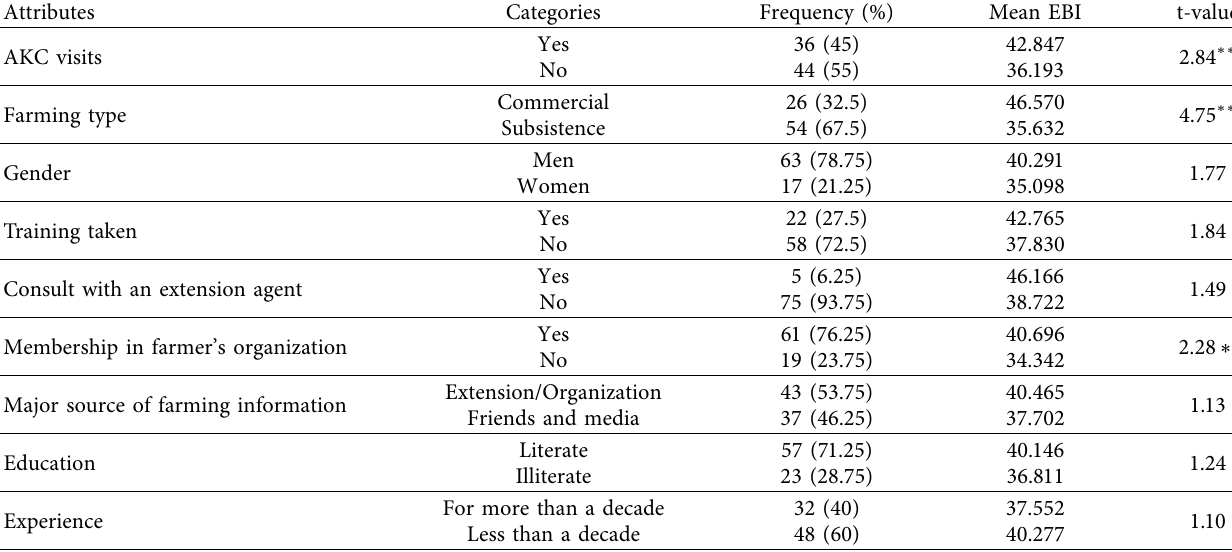
Table 4: Mean EBI comparison among various attributes of